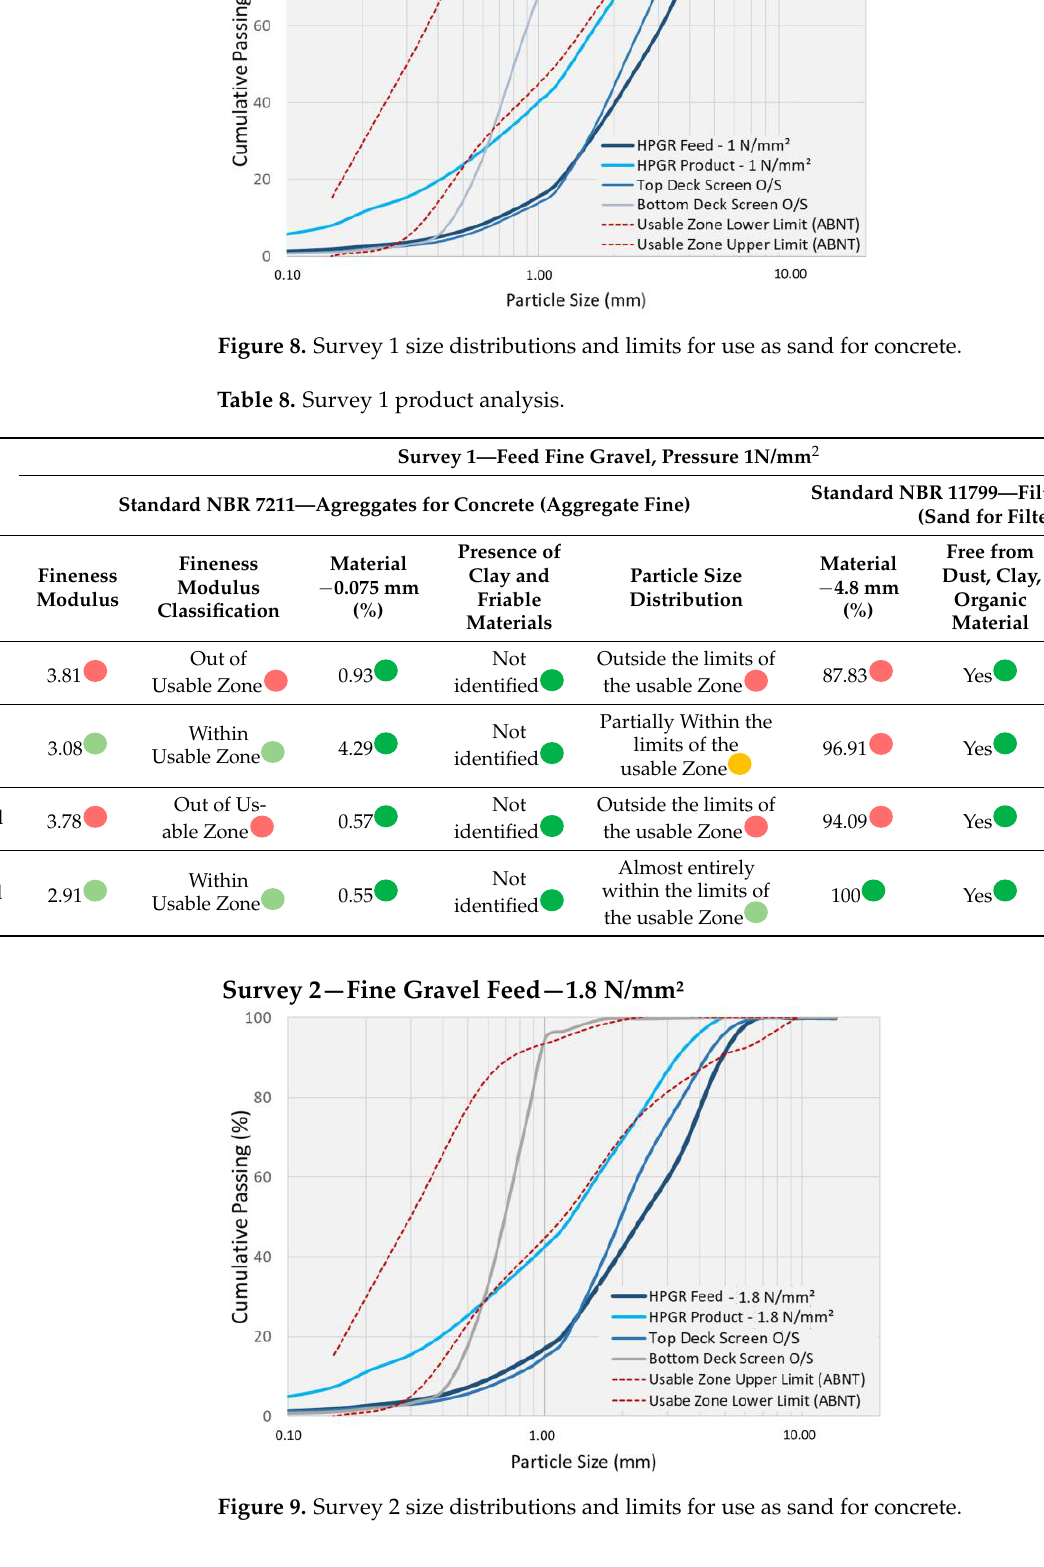
Figure 9. Survey 2 size distributions and limits for use as sand for concrete. Table 9. Survey 2 product analysis.